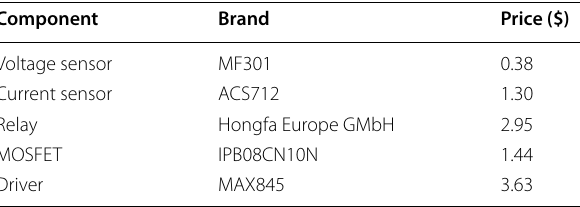
Table 5 Price of the required hardware of the dynamic PV reconfiguration method